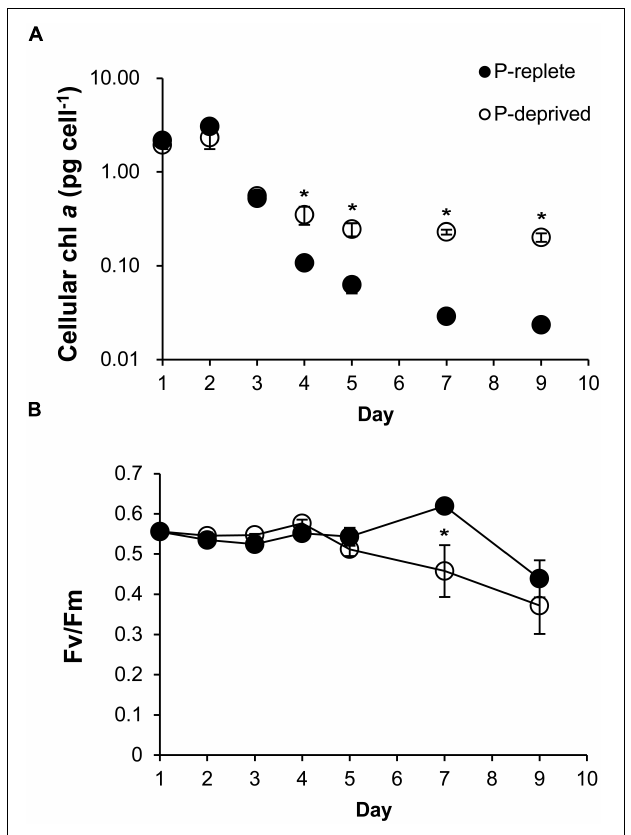
FIGURE 3 | Cellular chlorophyll a (A) and the maximum photochemical efficiency of PSII ( F v/ F m; B) of A. carterae under P-replete and P-deprived conditions. Shown are means ± standard deviations (error bars) from the triplicated cultures. Asterisks represent that significant differences between P-replete and P-deprived conditions were detected ( p < 0.05).